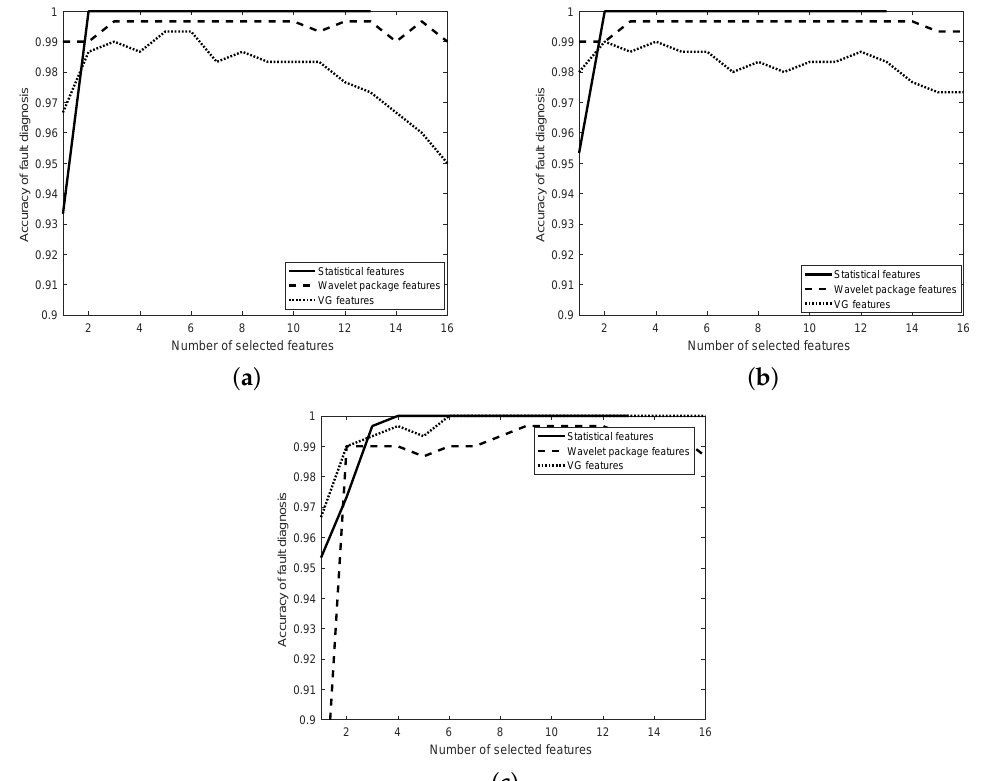
Figure 6. Estimated accuracy during feature selection for all features using IMS data. ( a ) KNN; ( b ) LSVM; ( c )